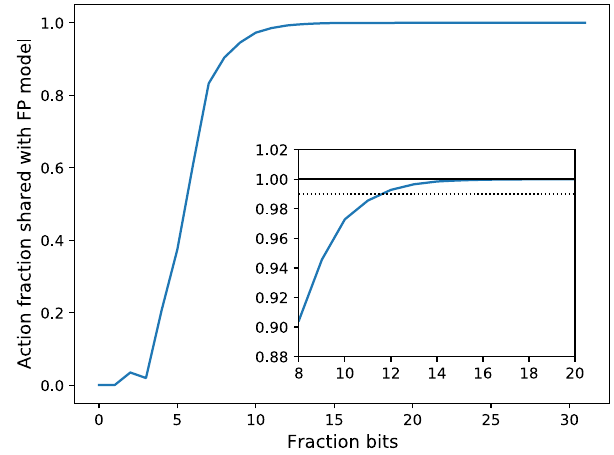
FIG. 9. The fraction of decisions that the quantized NN implementation shares with the floating-point calculation across a set of representative input Booster data is shown as a function of the fixed-point precision. Here the number of bits to encode the integer part is fixed to five plus a sign bit, while the number of bits encoding the fractional part is varied. The inset shows the same measurements, highlighting the region where the shared action fraction is over 90%. At very low precision, statistical fluctua- tions are observed that depend on the specific model weights and rounding conventions.